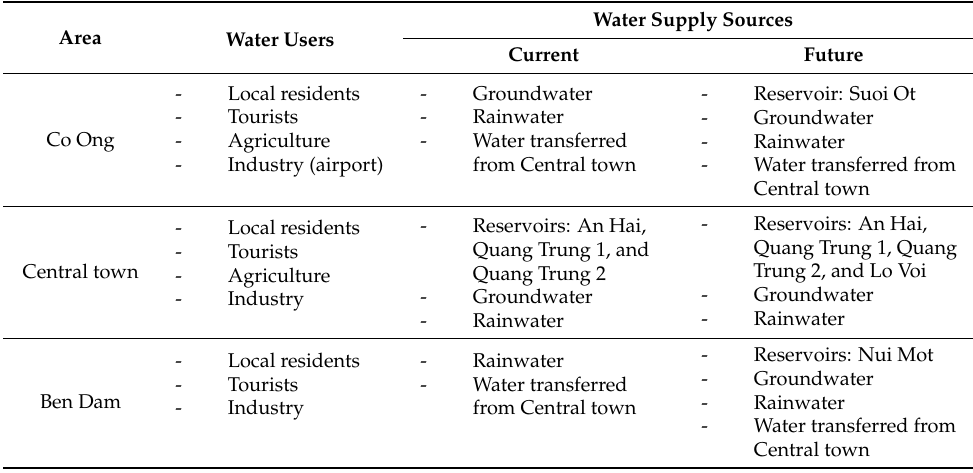
Table 1. Water users and water supply sources for different areas in Con